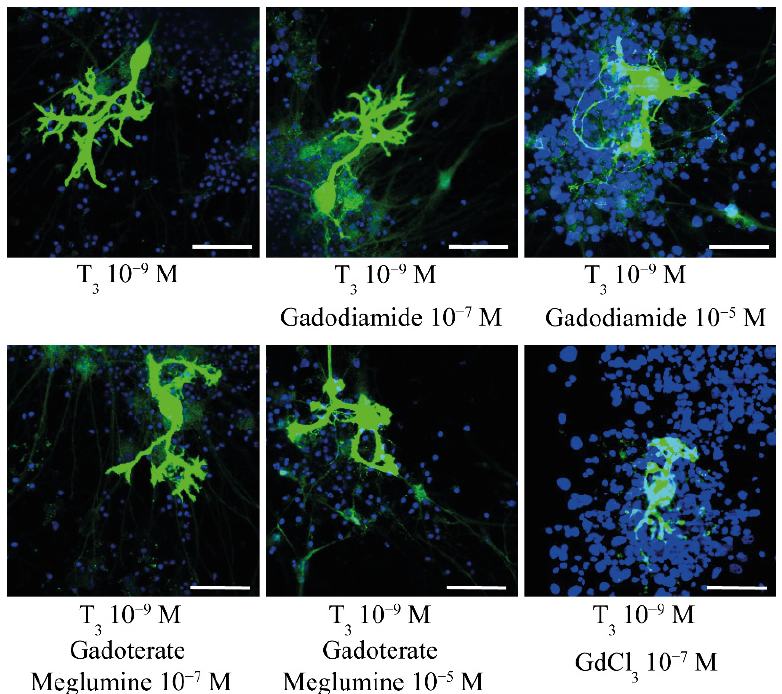
Figure 1. Representative photomicrographs showing the effects of gadodiamide (Gd − DTPA − BMA), gadoterate meglumine (Gd − DOTA), and GdCl 3 on T 3 -mediated dendrite arborization of mouse Purkinje cells. Scale bar, 50 µ